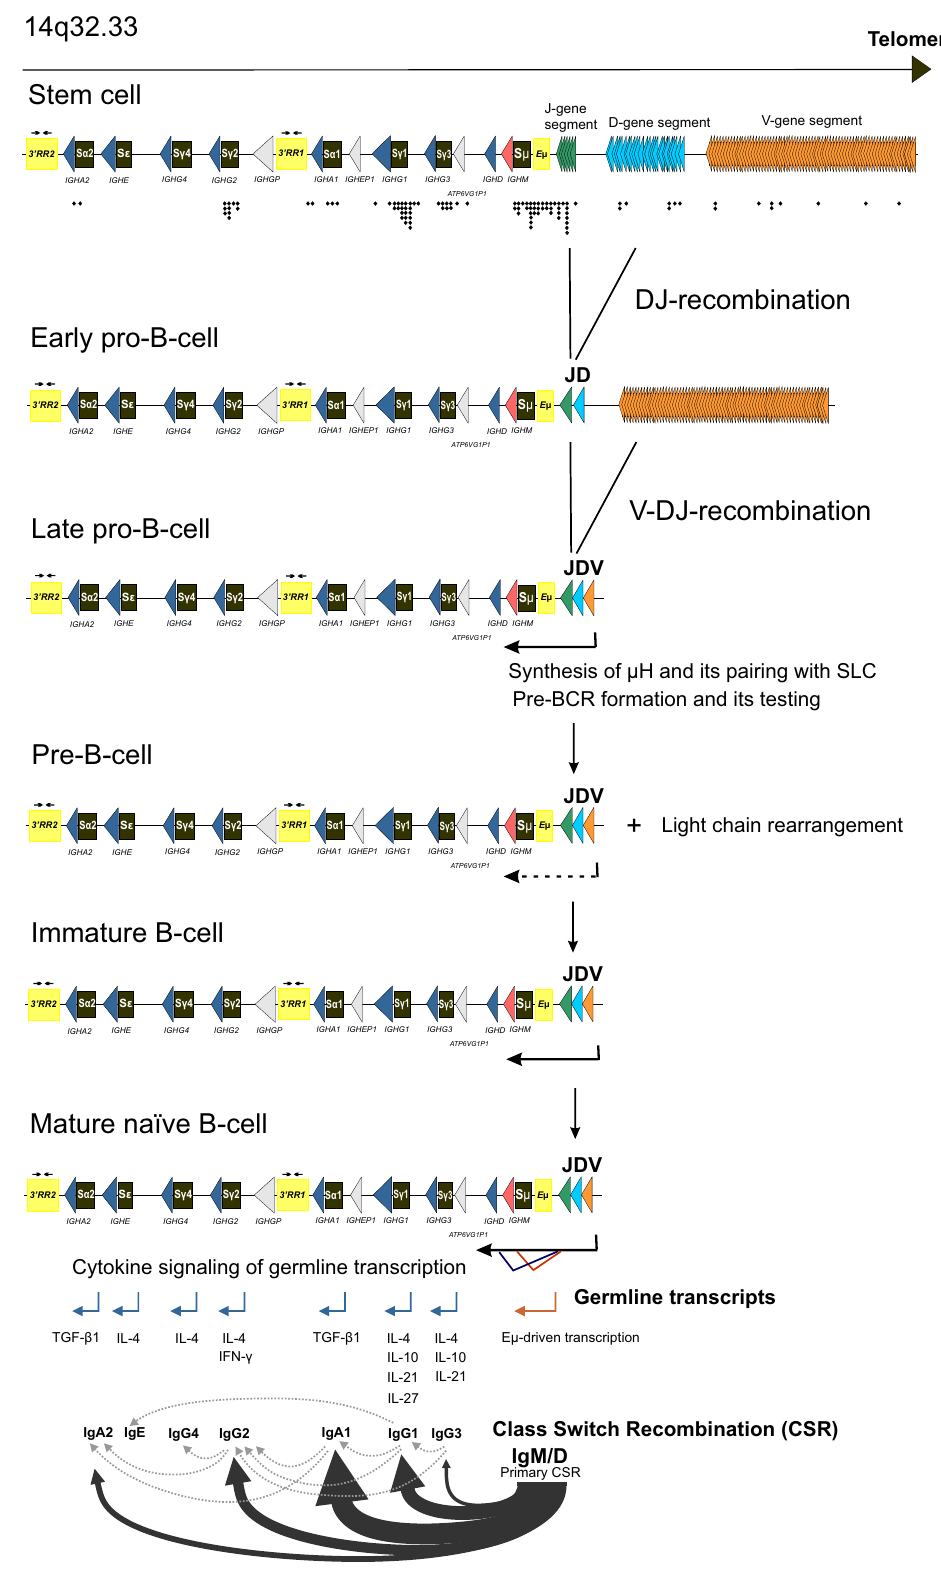
Figure 5. The schematic map of the human IGH locus illustrating events occurring during B-cell development. V(D)J rearrangement and CSR are thought to be the two main sources of genomic instability leading to the IGH translocations in MM. Translocation breakpoints mapped in MM are shown as black circles under the corresponding elements of the